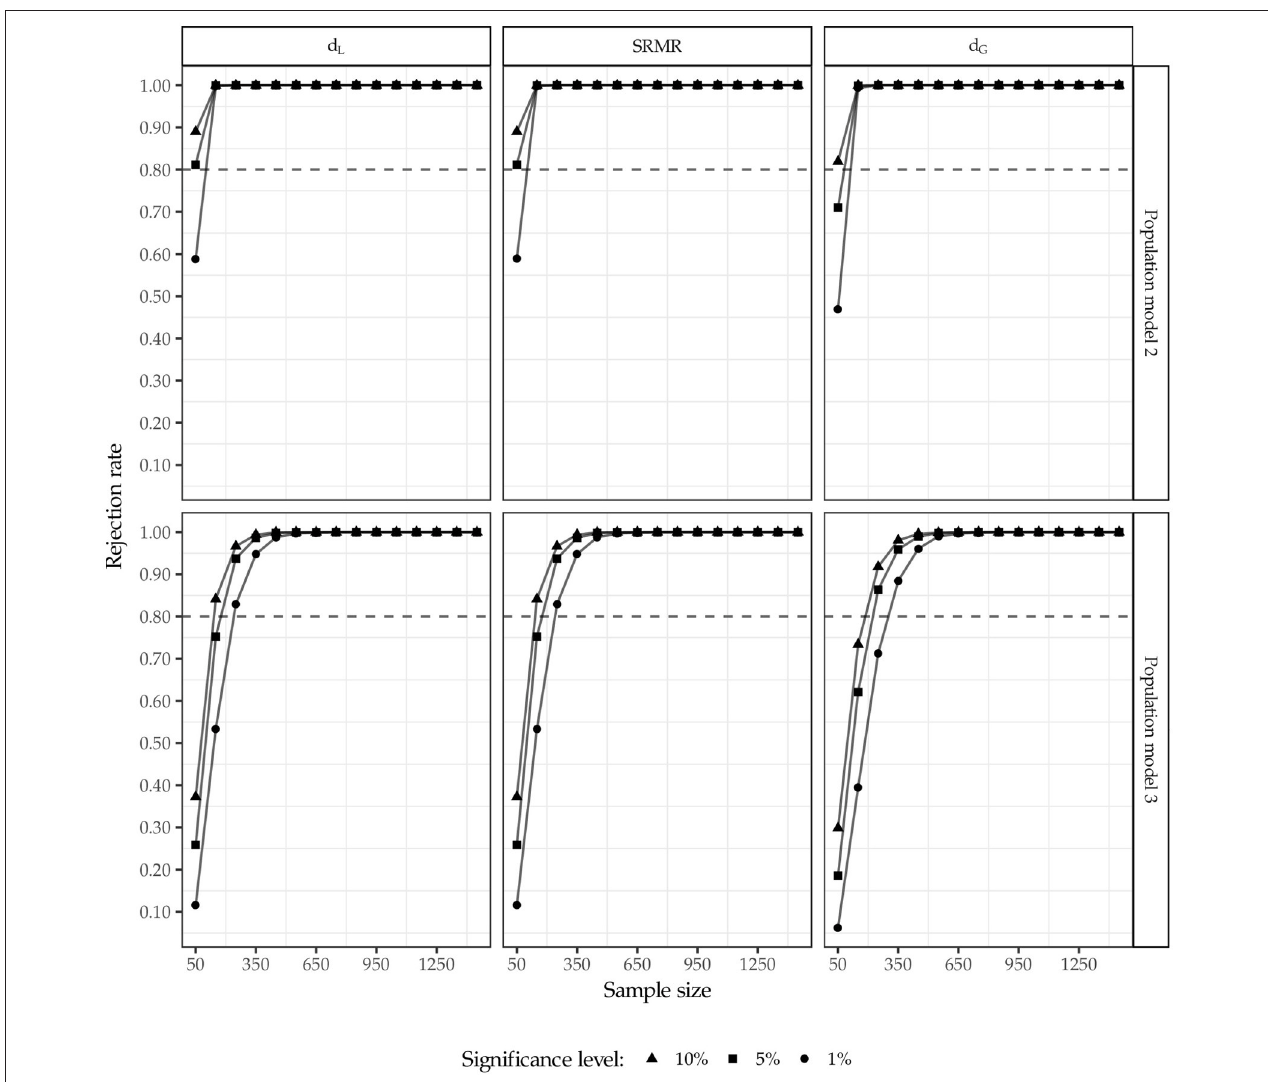
FIGURE 7 | Rejection rates for population model 2 and